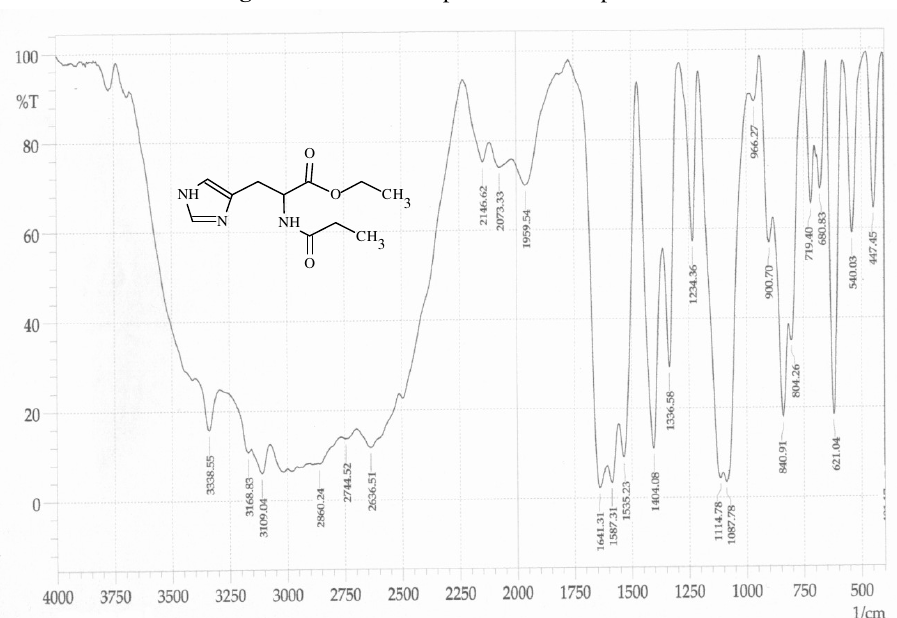
Figure 3 . The FT-IR spectrum of compound 4